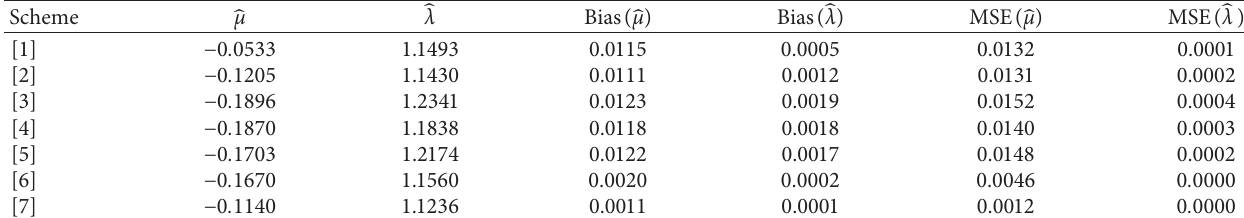
Table 7: MLEs 􏽢 μ , 􏽢 λ , biases, and MSEs for μ and λ from APE distribution when α � 2 . 5. Scheme